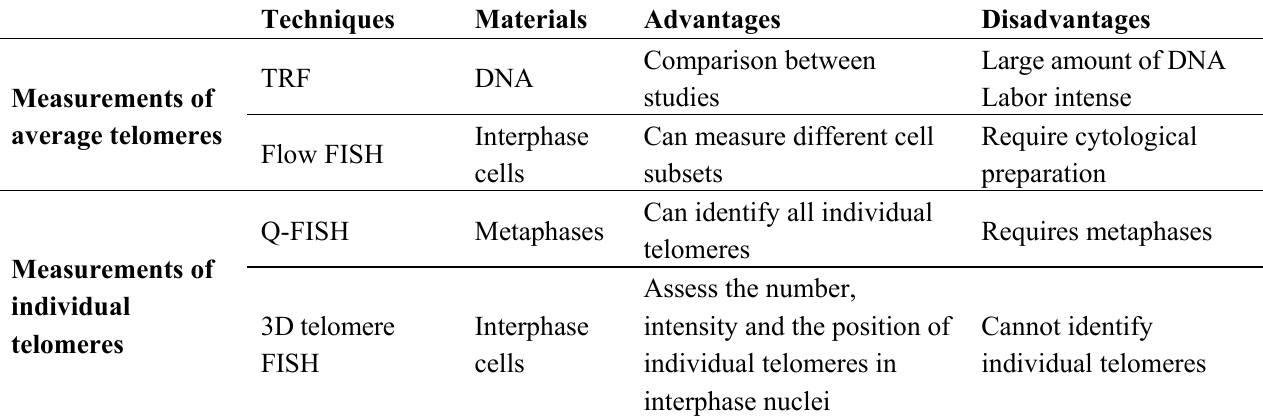
Table 1. Comparison of widely used techniques for the measurement of telomere lengths in